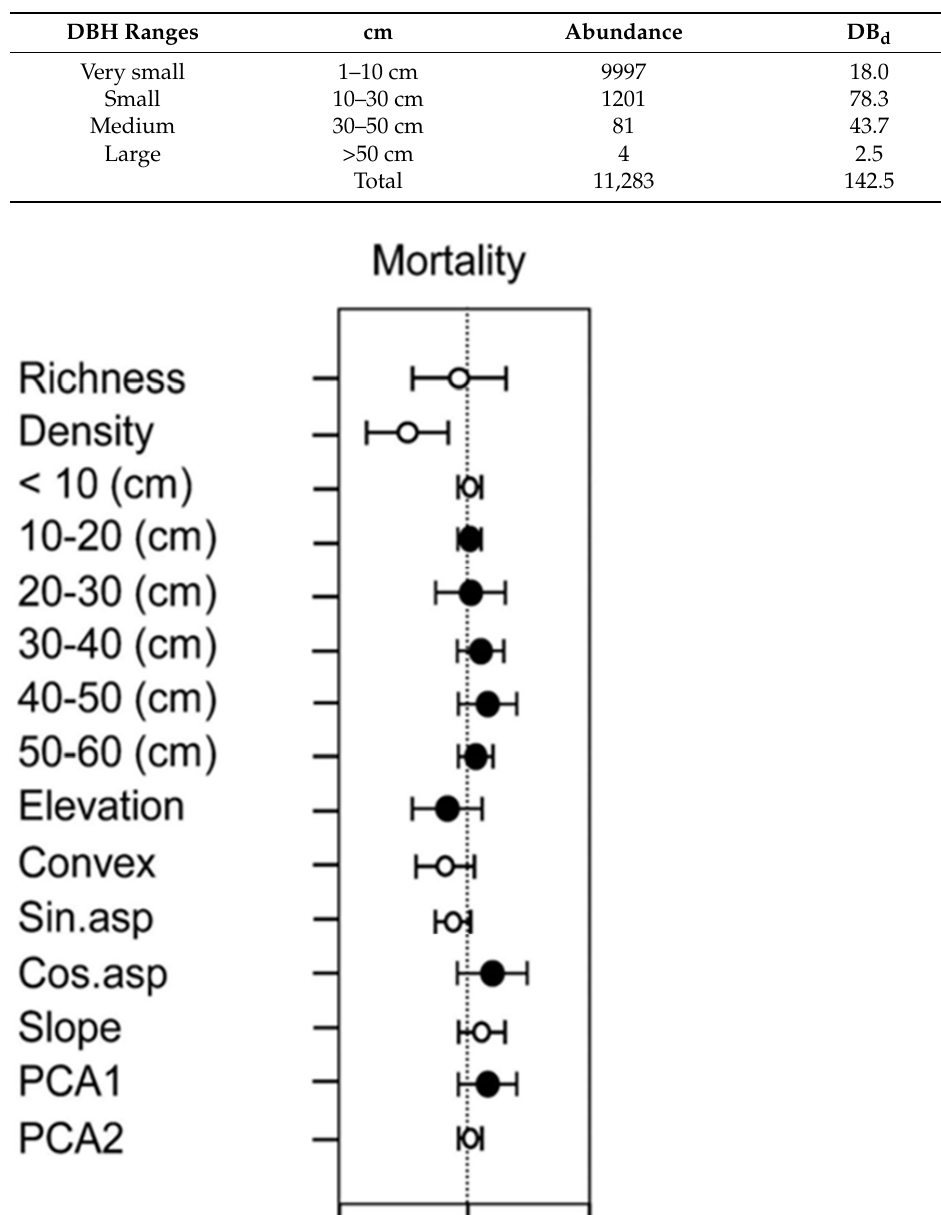
Table 1. Deadwood density, abundance, and biomass (DB d in t) across DBH ranges within the 20 ha subtropical forest plot.